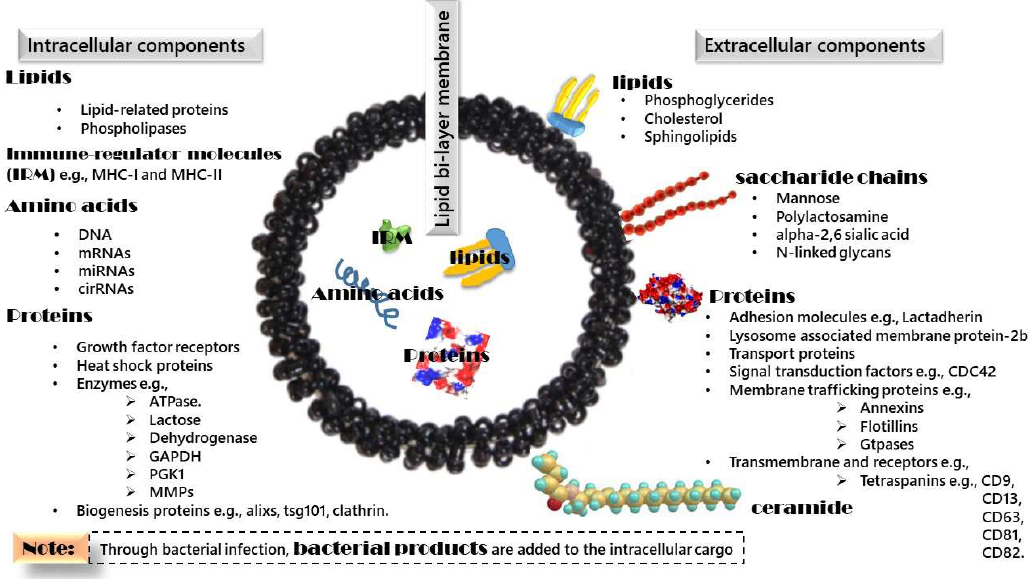
Figure 1. The exosome structure in mammalian cells.